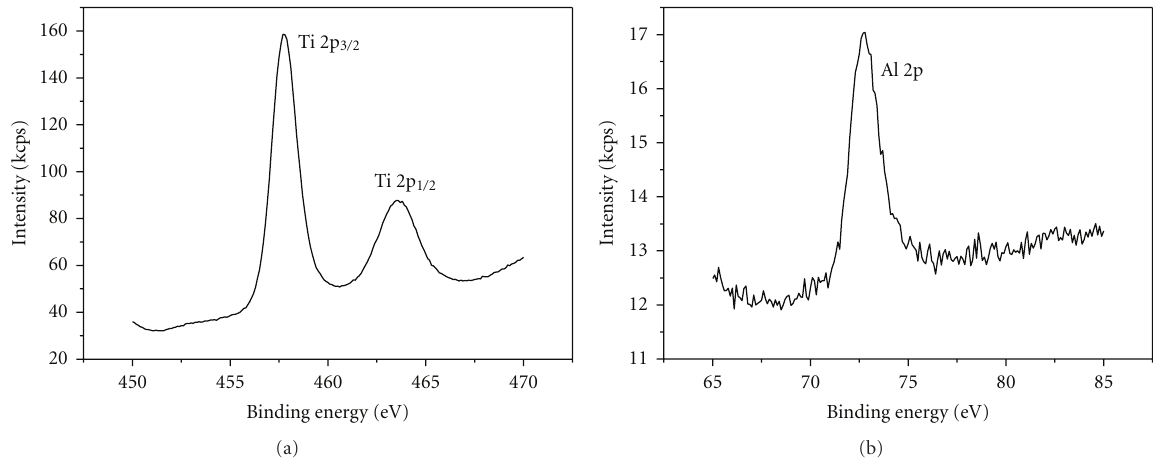
Figure 7: (a) Ti 2p and (b) Al 2p XPS spectra for the oxide film potentiodynamically grown on the Ti6Al4V alloy, in PBS